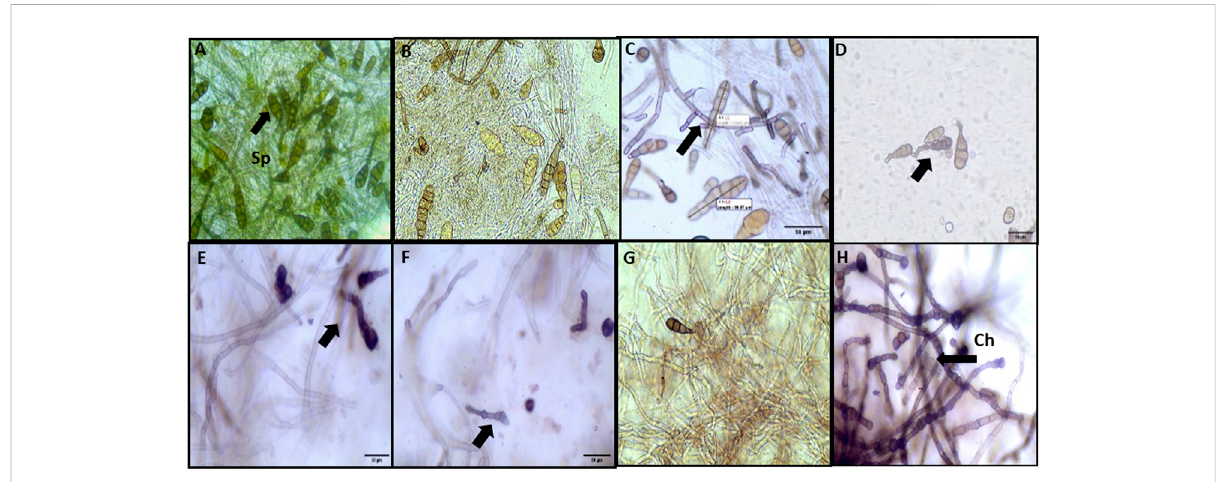
FIGURE 10 Microscopic observations of the effect of M - CuO NPs on the morphology of A. brassicae : (A) control: long obpyriform conidia; (B,C) 25 and 50 ppm:nosigni fi cantchangeintheshapeofconidia; (D – F) 100,150 ppm,and200 ppm:bendinginthebeakofconidia; (G) mancozeb:fracturesin hyphae; and (H) propiconazole: chlamydospore (Ch) formation in hyphae and collapsed